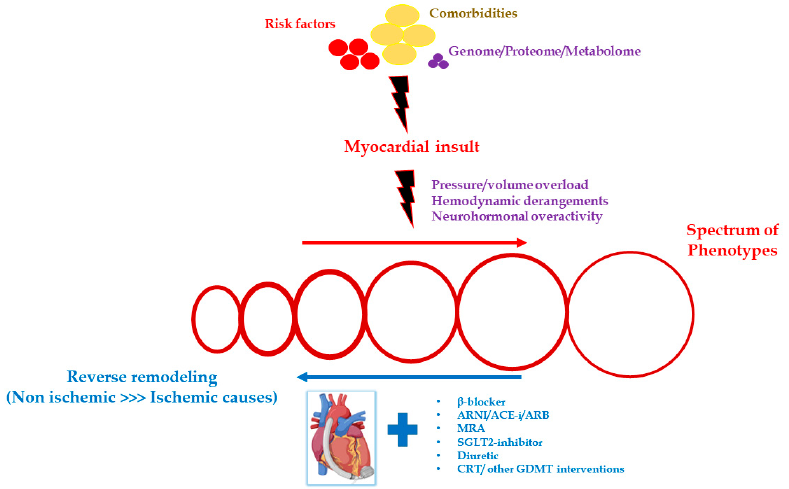
Figure 5. Heart failure (HF) is a spectrum of phenotypes. Each HF phenotype is the result of a patient-specific trajectory wherein the heart remodels towards concentric hypertrophy, eccentric hypertrophy or a combination of both. The way of entry and the subsequent path of the trajec- tory depend on the patient’s risk factors, comorbidities and disease modifiers (genome, proteome, metabolome). Both pharmaceutical treatment (i.e., β -blocker, ARNI/ACE-i/ARB, MRA, SGLT-2 inhibitor, diuretic) and device therapy (i.e., cardiac resynchronization therapy, left ventricular assist devices) may lead to reverse remodeling. Abbreviations: ARNI, angiotensin receptor-neprilysin inhibitor; ACE-I, angiotensin-converting enzyme inhibitor; ARB, angiotensin receptor blockers; MRA, mineralocorticoid receptor antagonists; SGLT2-inhibitor, sodium-glucose Cotransporter 2-nhibitor; CRT, cardiac resynchronization therapy; GDMT, guideline medical